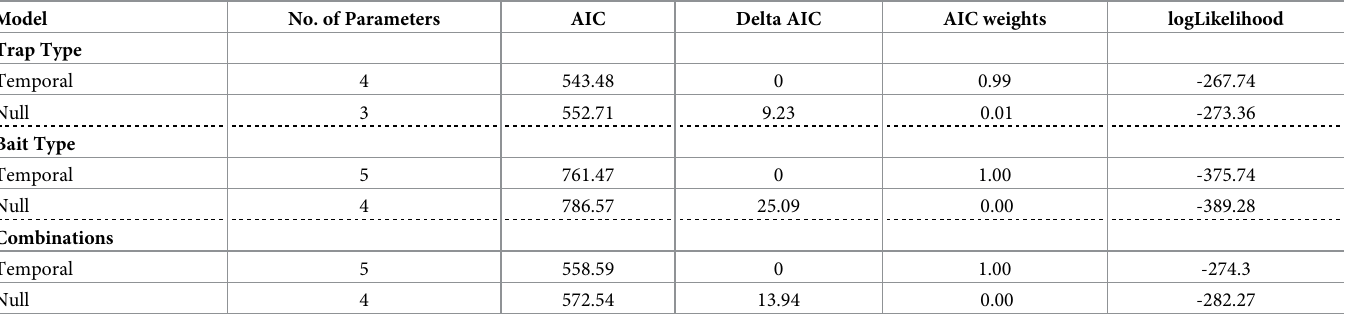
Table 2. Values of AICc, delta AIC, AIC weights, and loglikelihood for occupancy models used to determine effect of different trap and bait types on detection probability of pocket mice.